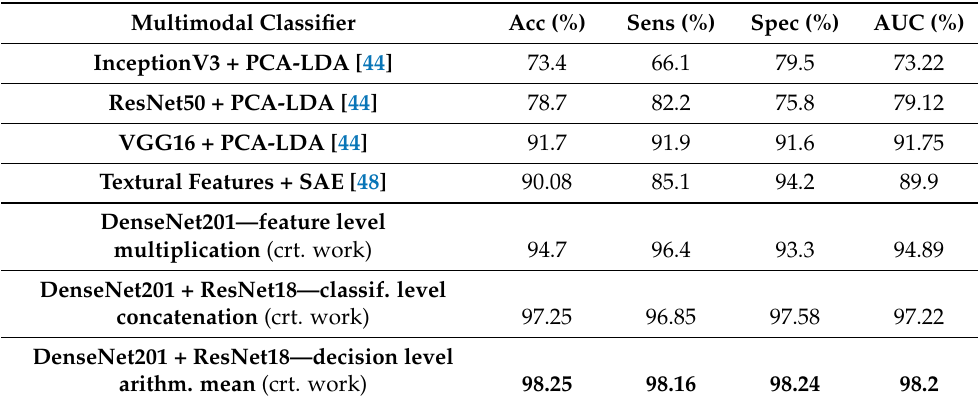
Table 10. Comparison with state-of-the-art